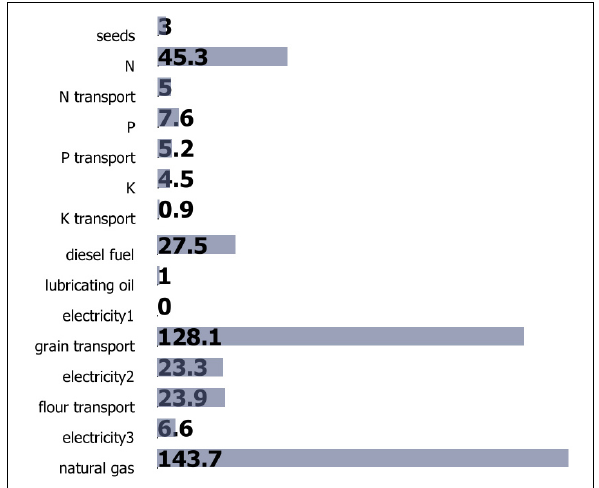
Figure 10. Amount of non-renewable primary energy (MJ / person * year) associated with a bread supply chain, average Italian practice, 41,7kg/person*year (Magentino-Abbiatense